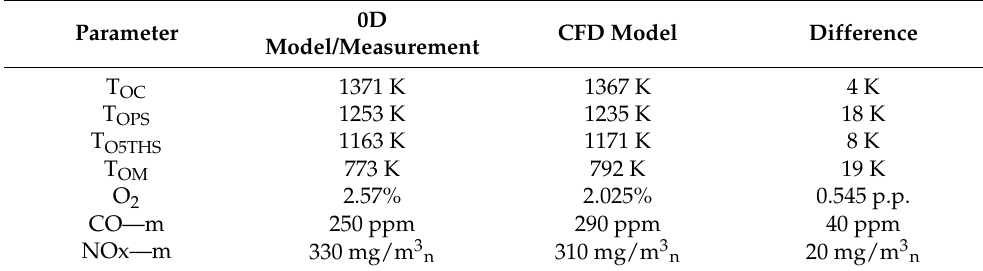
Table 8. Summary of the parameters of the verification results.